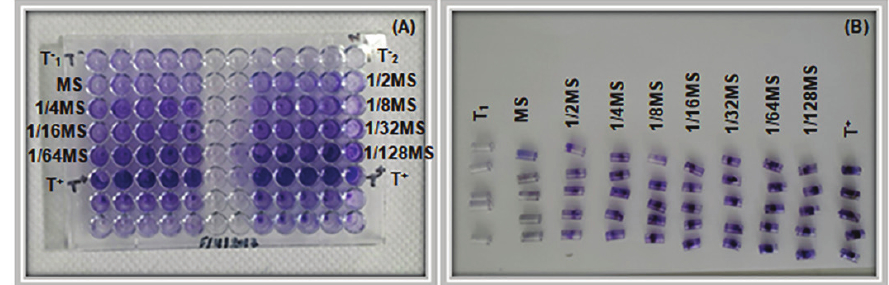
FIGURE 4 - Antibiofilm effect of methanolic extract of P. nigra (ME.Pn) on MRSA, in 96-well microplate (A), and ethyl acetate fraction of P. nigra (AF.Pn) on B. subtilis , in venous catheter